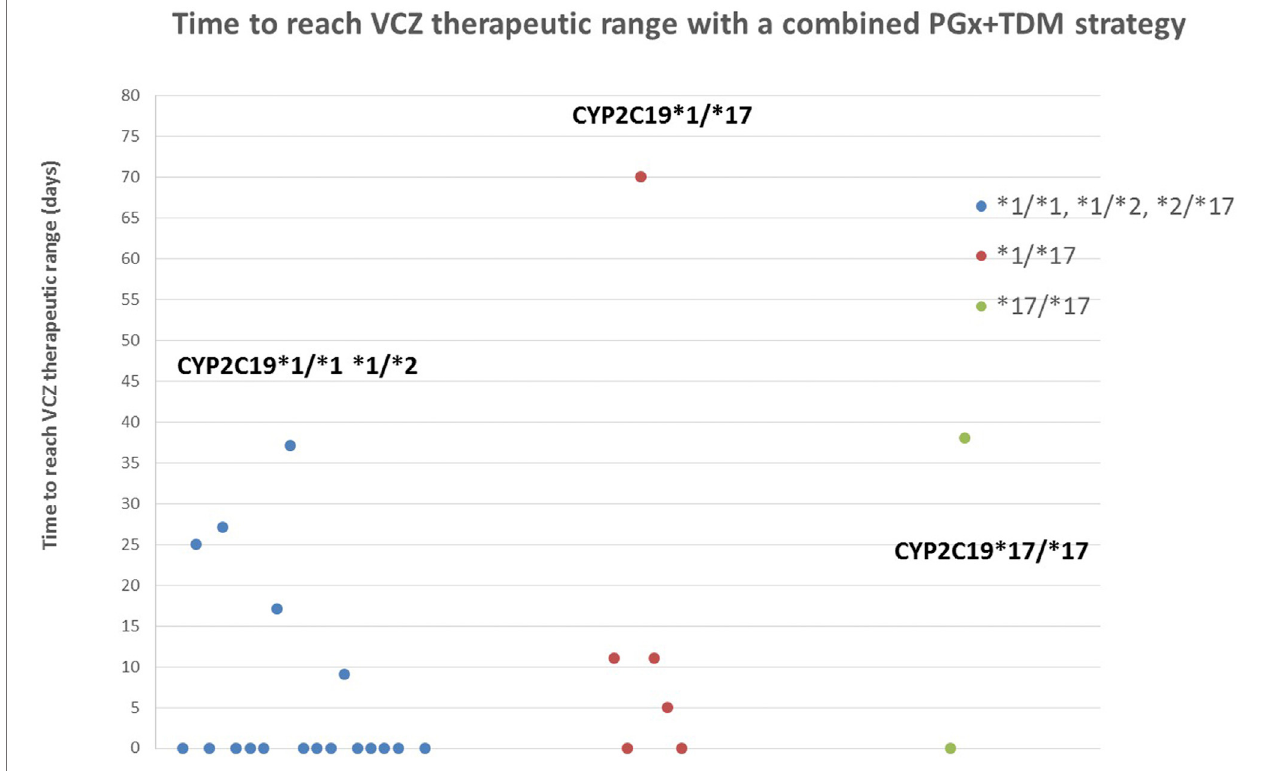
TABLE 3 | Percentage of patients a /troughs b within goal therapeutic range. Comparison of our results (A) with those found in Hicks et al. ’ s study with standard care and (B) simulation with extrapolated doses (C). Study Cohort ( N = 28) Hicks et al. ( N = 33) (A) % of patients in goal therapeutic range: fi rst measure after initial dose adjustment based on PGx